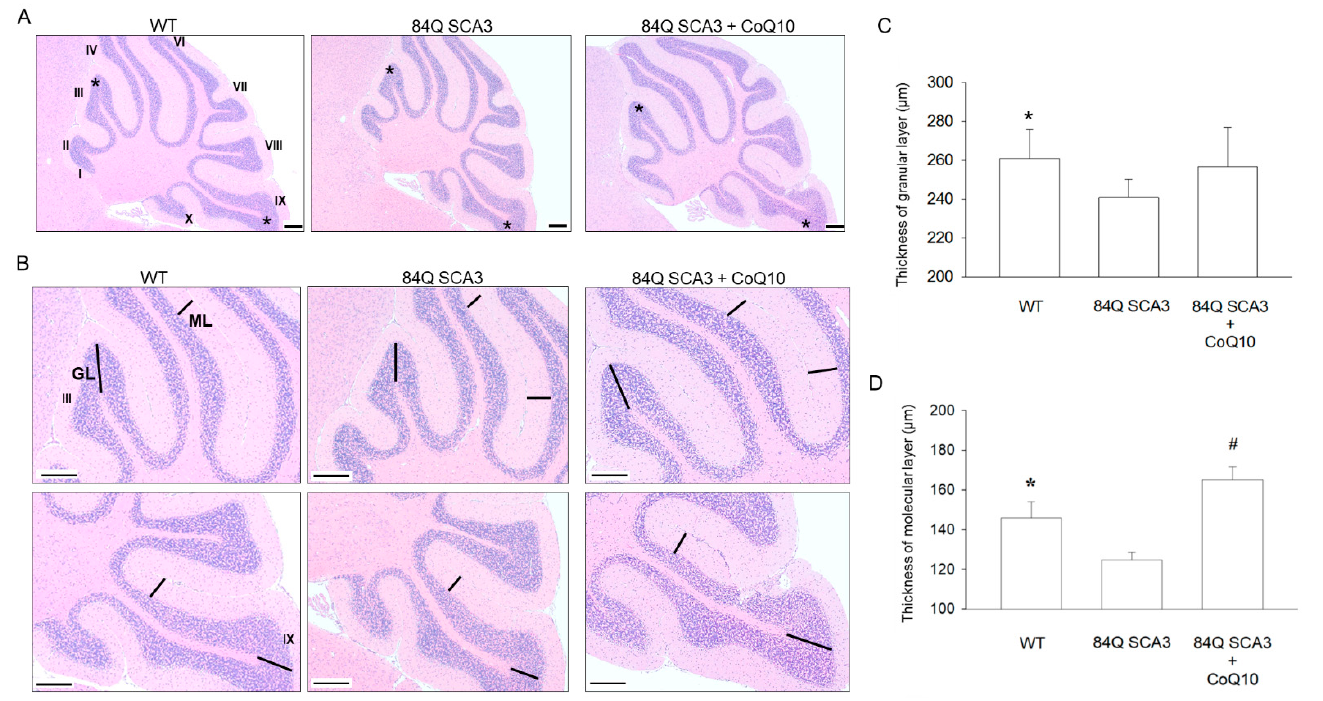
Figure 3. Effects of CoQ10 on the granular (GL) and molecular layers (ML) of the cerebellar cortex in 84Q SCA3 mice. ( A ) Graphs represent the H&E staining of the sagittal section of the cerebellum near the junction of the vermis (approximate 1 mm) at the age of 16 months. Histological sections of the cerebellar vermis show the stereotypical foliation pattern and the asterisk in III and IX lobules indicate the sampling area. ( B ) Magnification images of the sampling area shows that the GL thickness of cerebellar tissue was determined from the distance from the tip of the GL to the white matter, in contrast to the ML thickness, determined by the distance from the GL to the edge of the ML, which is indicated by the black line. ( C ) Quantification of the average thickness of the GL and ( D ) ML. Data are presented as the mean ± SD. Scale bars, 200 μ m. * p < 0.05 indicates the WT group compared to the 84Q SCA3 group. # p < 0.05 indicates the 84Q SCA3 + CoQ10 group compared to the 84Q SCA3 group. WT, wild-type controls; 84Q SCA3, chow diet of vehicle; 84Q SCA3 + CoQ10, CoQ10